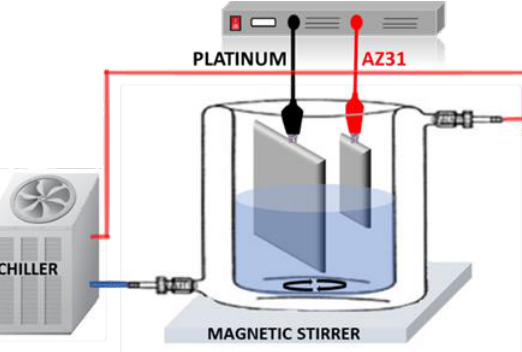
Figure 1. Schematic diagram of the system used to perform the electrochemical treatment. AZ31 alloy specimens and a platinum sheet were used as the anode and cathode, respectively, and connected to a power source (TDK-Lambda, Milan, Italy). A magnetic stirrer operating at 200 rpm continuously mixed the electrolytic solution during PEO treat- ment. A circulating system of cooling water was employed to keep the temperature at 18 °C. The PEO treatment was conducted by applying two current density values, i.e. , 15 and 30 mA/cm 2 , for 20 min in an electrolytic solution consisting of 5 g/L Na 2 SiO 3 and 2 g/L obtained using a phosphate-based solution [20], at pH 12 and with an electrical conduc- tivity of 20.3 mS/cm.